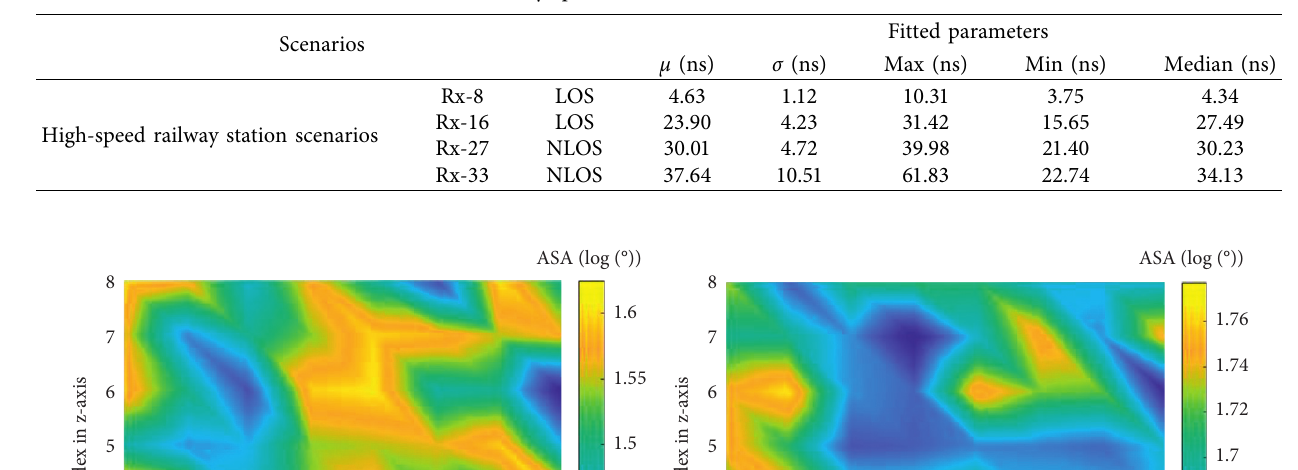
Table 3: RMS delay spread values for LOS and NLOS scenarios.